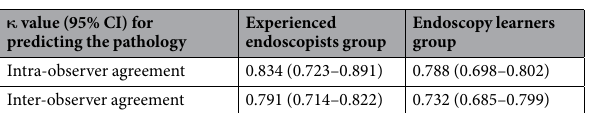
κ value (95% CI) for predicting the pathology